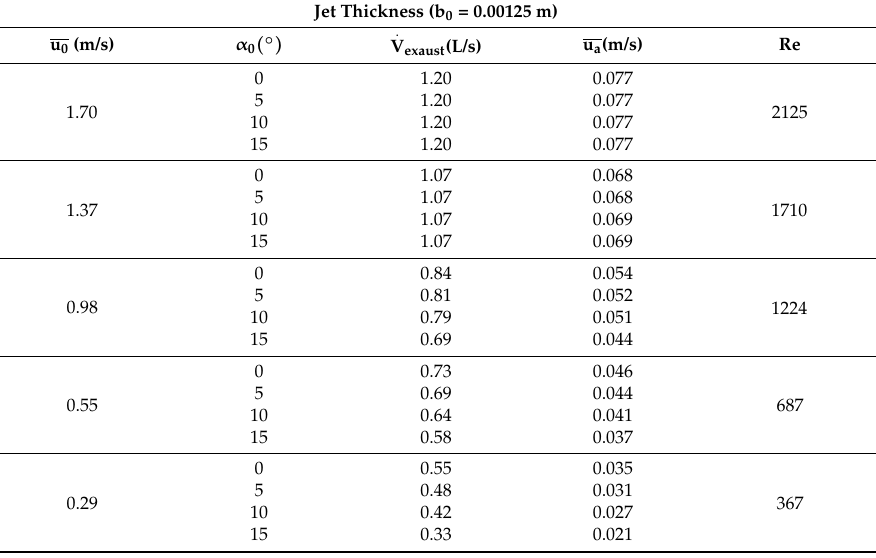
Table 2. Test results obtained with both active (thickness of 0.00125 m) and inactive